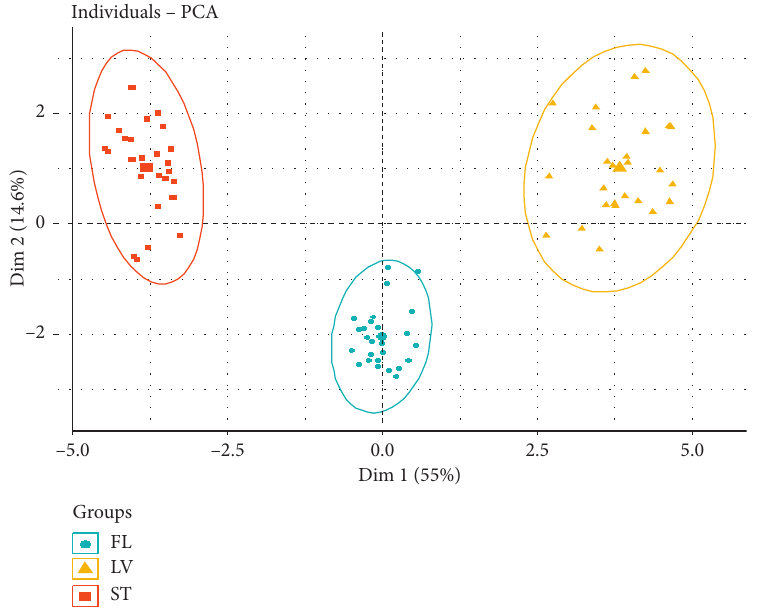
Figure 2: Superimposed representation of three parts of the plant.